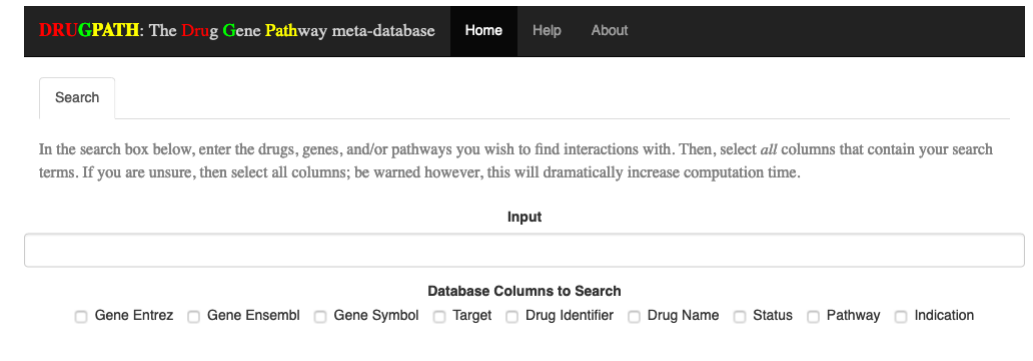
Figure 1. DRUGPATH Graphical User